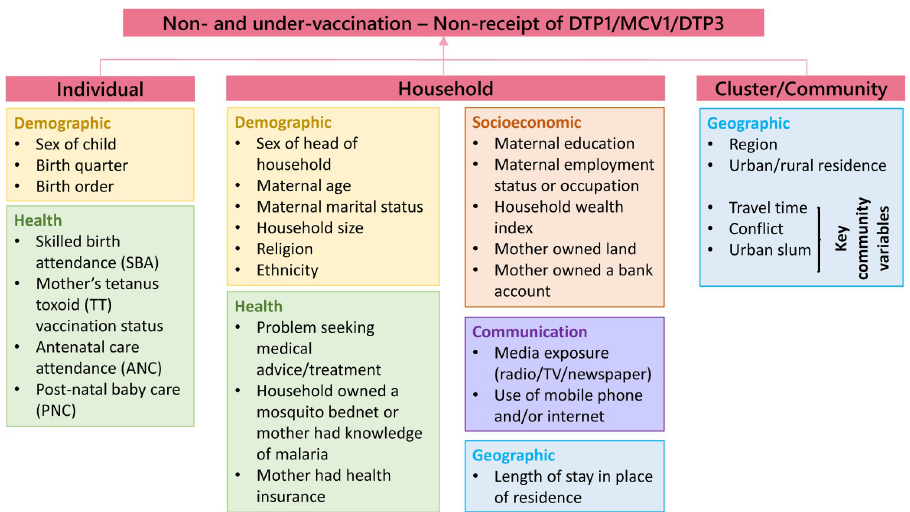
Fig 1. Outcome variables and groups of individual, household and community level covariates considered in the study. Further details are provided in Table A in S1 Text.